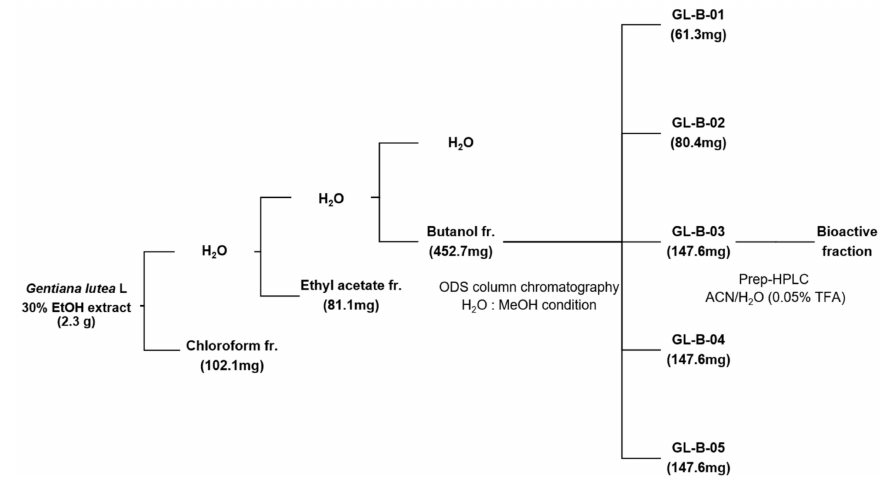
Figure 1. Extraction and purification of loganic acid from Gentiana lutea L. (GL). Ethanol extract of GL (30%) was fractionated using chloroform, ethyl acetate, and butanol. The butanol fraction was further fractionated into five sub-fractions by octade- cylsilyl (ODS) gel column chromatography and eluted with acetonitrile (ACN) solution containing 0.05% trifluoroacetic acid (TFA) in a step-gradient manner (10 to 40%). Finally, a single bioactive compound was obtained. fr: fraction, HPLC: high-performance liquid